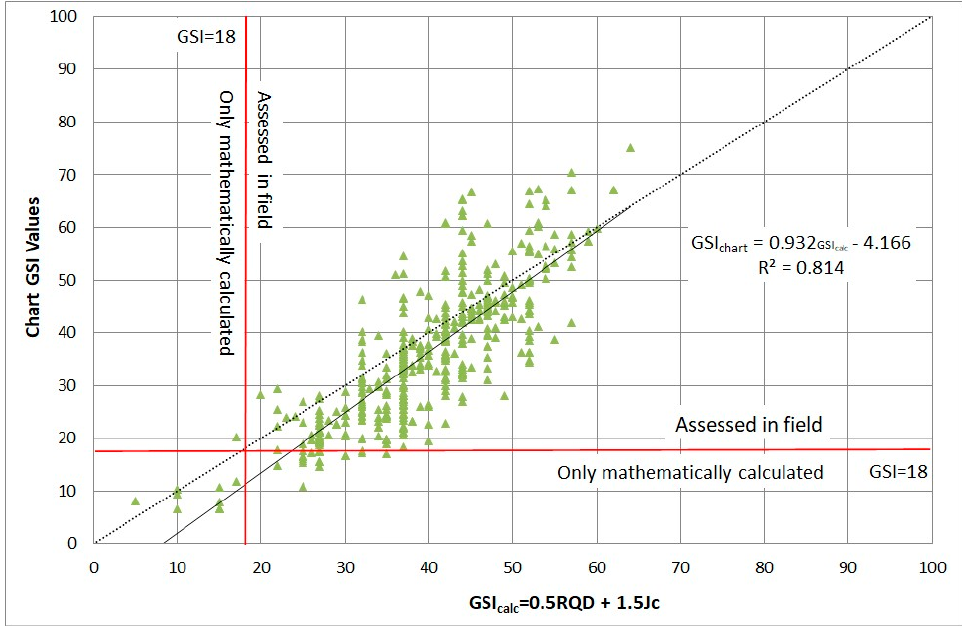
Figure 6. Correlations between Chart and calculated GSI values using Equation (3).